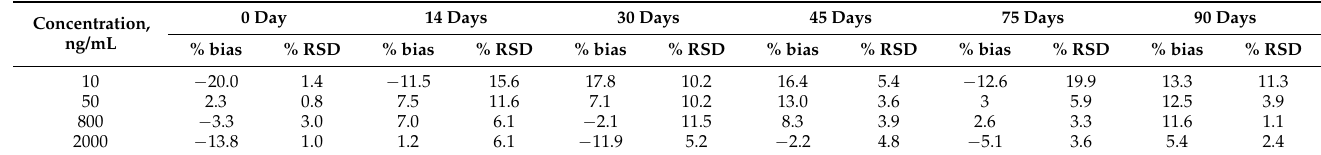
Table 4. Stability of ST-246 (tecovirimat) in plasma at − 20 ◦ C for three months.